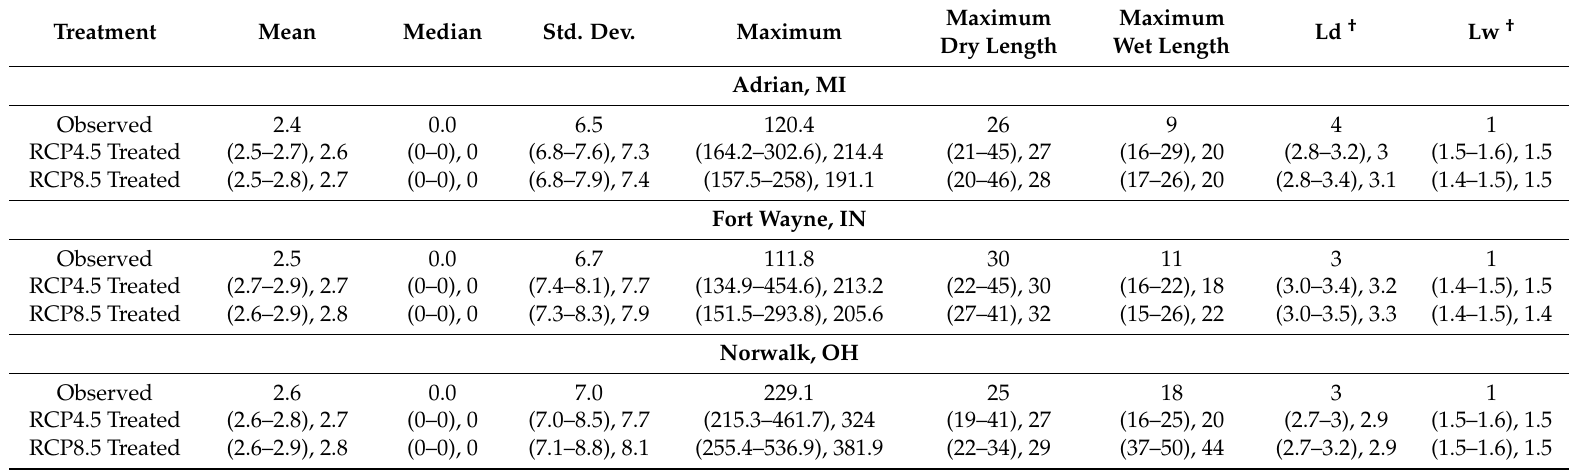
Table 6. Comparison of future climate scenarios (2006–2099) with the historical period (1966–2005) for daily precipitation,